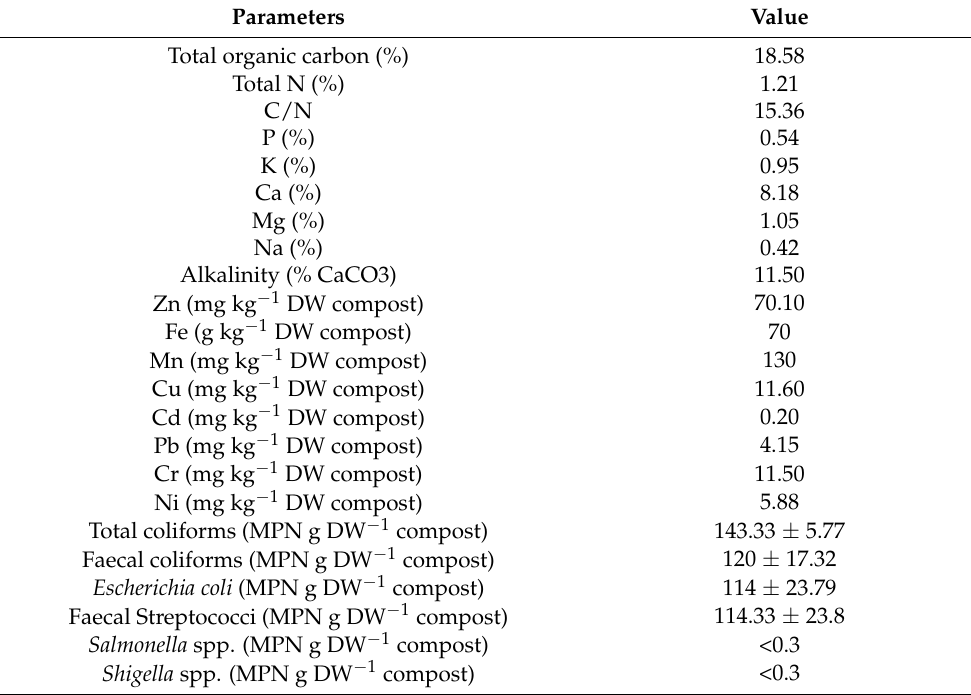
Table 3. Physico-chemical properties of the experimental